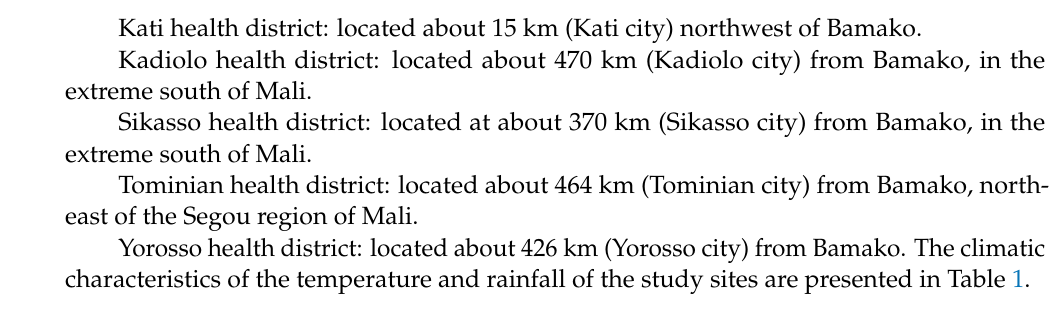
Table 1. Climatic characteristics (rainfall and temperature) at the study sites from 2016 to 2018. Health District Average Annual Rainfall (mm) Average Annual Temperature ( ◦ C) Kati 789.6